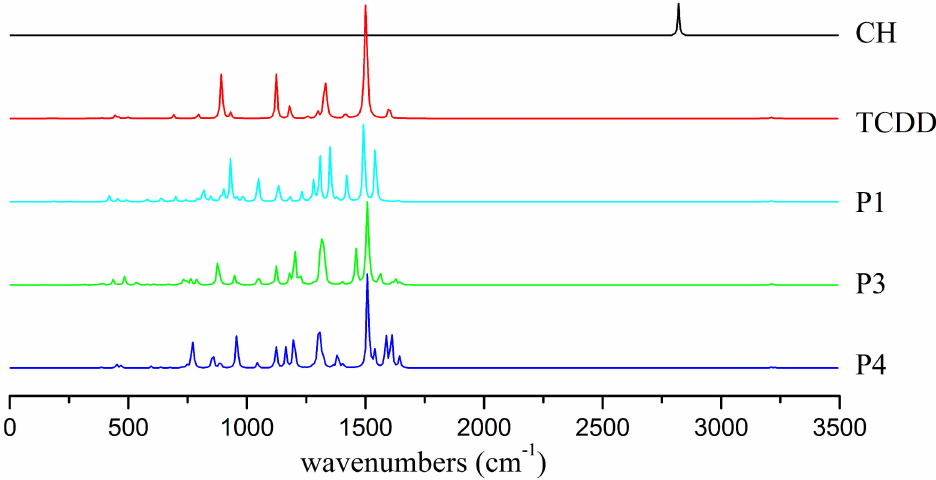
Figure 9. IR spectra of the monomers and major